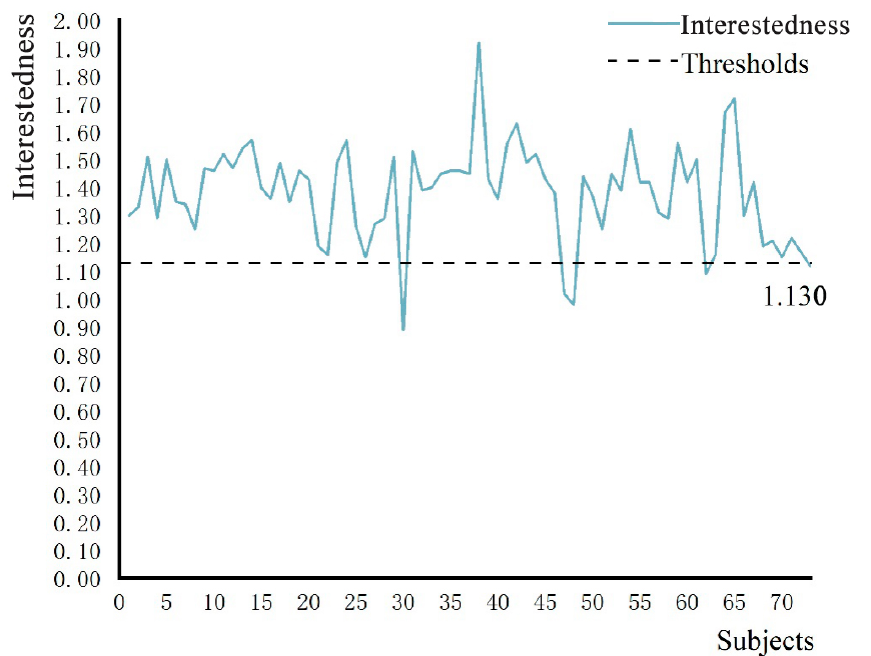
Figure 6. Variation trend of subjects’ level of interest. Source: ErgoLAB platform derived the data, and the weight threshold of the level of interest was 1.130 when the time of the fixation point was the longest.